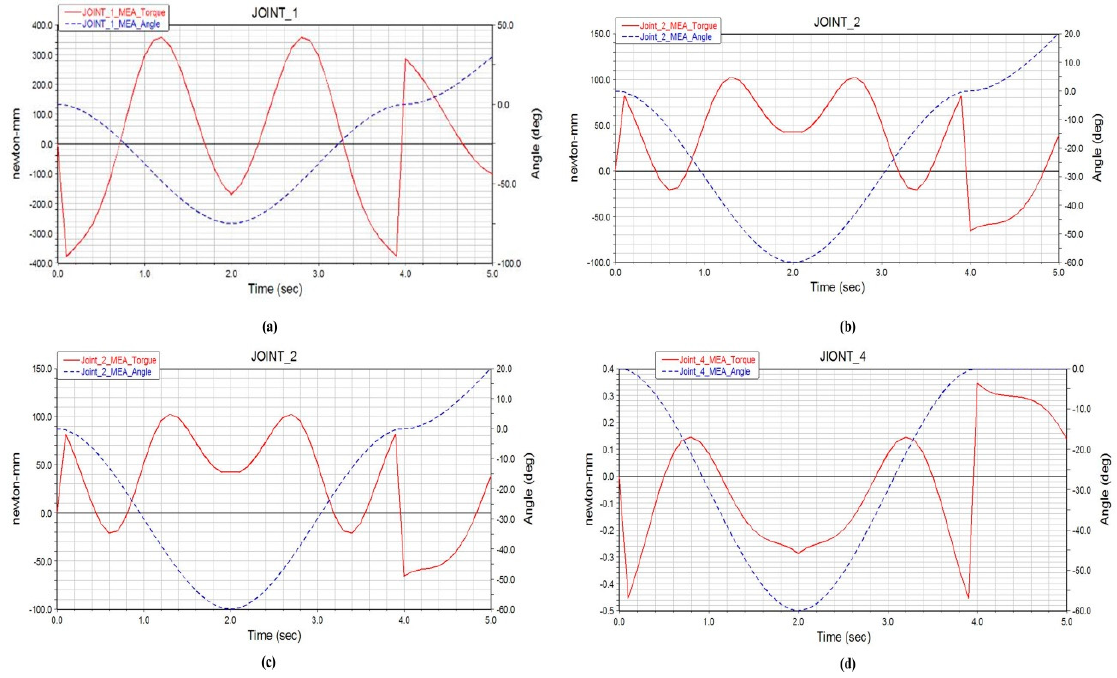
Figure 11. Torques and angles of joints. ( a ) The rotation angle and the output torque of the drive motor when the shoulder joint moves in the vertical direction at different moments; ( b ) the relationship between the angle of rotation and the torque on the worm gear when the shoulder moves horizontally; ( c ) the relationship between the rotation angle of the shoulder joint and the output torque of the motor; ( d ) relationship between elbow flexion and extension angle and driving torque.